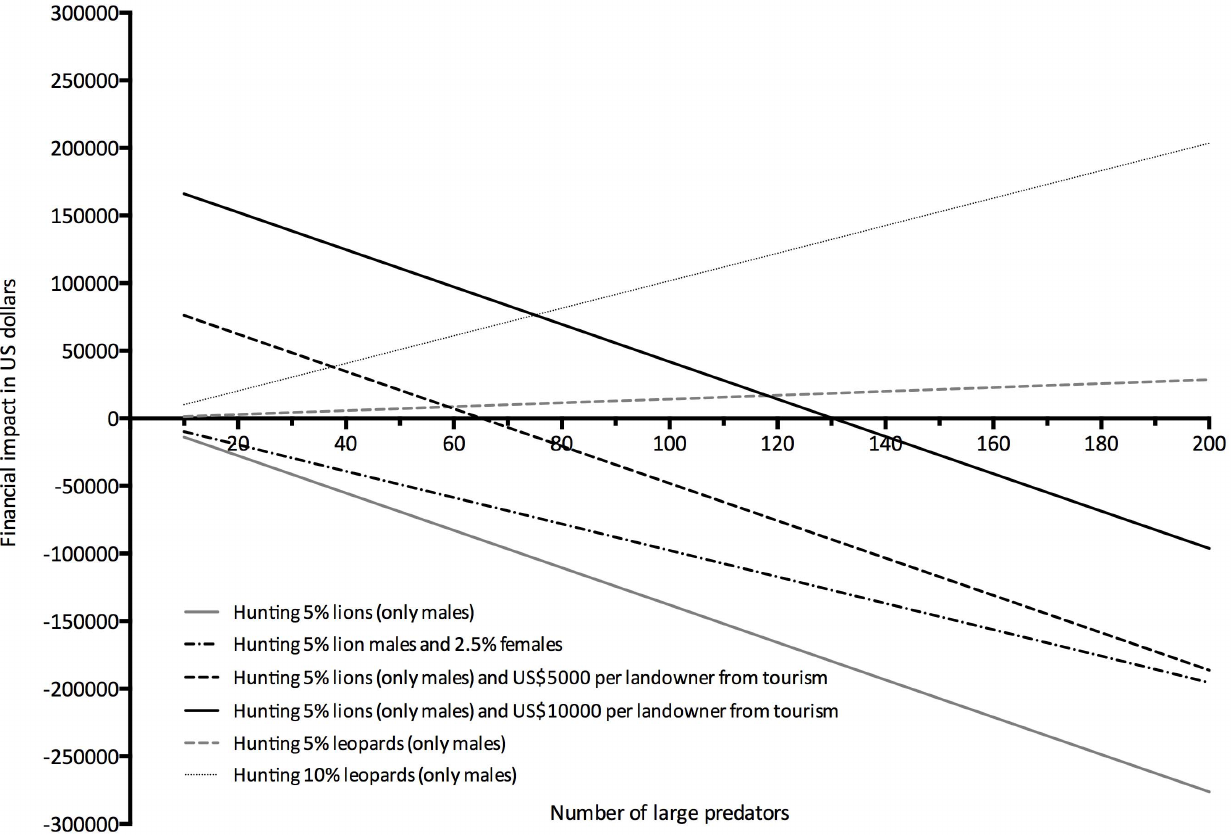
Figure 4. Projected net benefits of trophy hunting and photo-tourism based on 2009 trophy and day hunting fees for landowners in the Save´ Valley Conservancy using various hunting off-take percentages. The numbers of individuals is displayed on the X-axis.